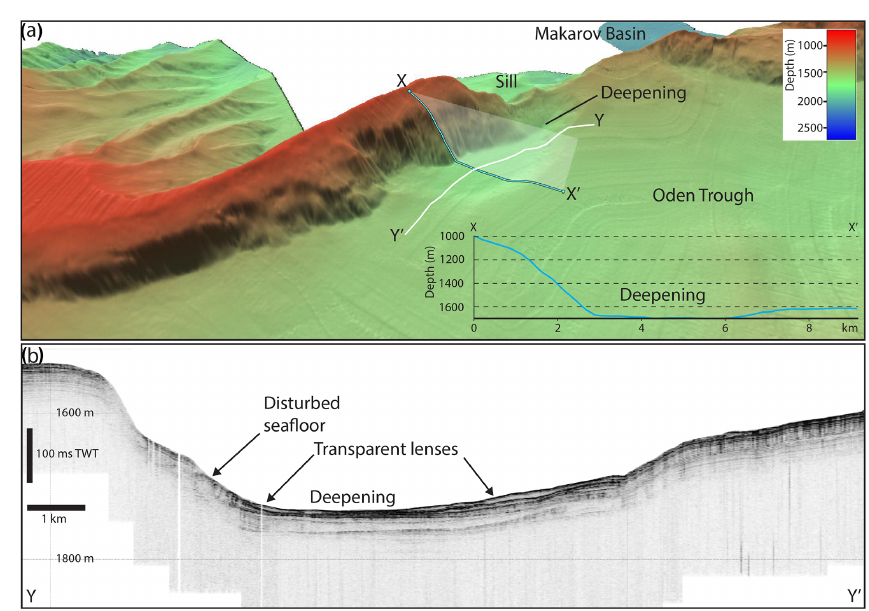
Figure 9. (a) Detail of the northern passage in the vicinity of the sill showing a deepening which is possibly formed by long term seabed erosion by bottom currents. (b) Sub-bottom chirp sonar data along the Y − Y (cid:48)